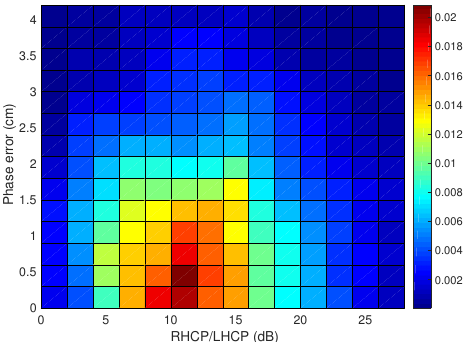
Figure 17. Relative frequency of the phase error measurements as a function of the RHCP to LHCP